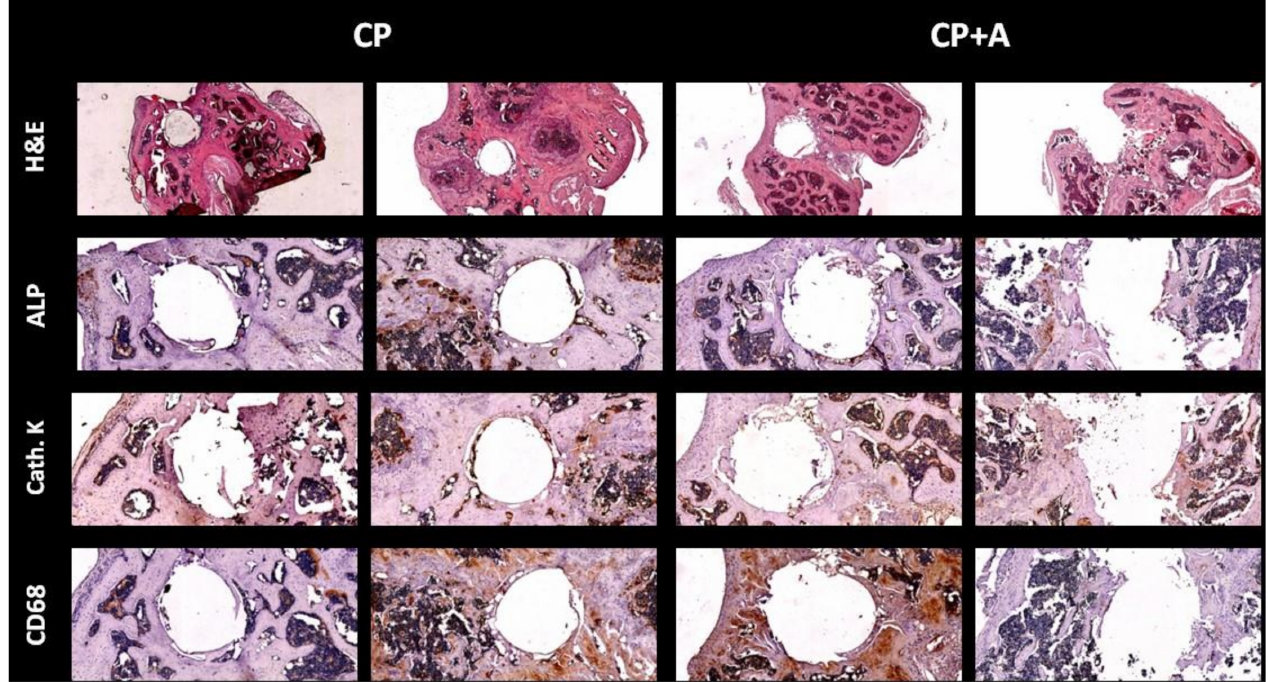
Figure 8. Immunohistochemistry for markers of different bone cells. Long bones were processed and immunohistology staining was carried out. Representative images stained for haematoxylin-eosin (H&E), tartrate-resistant acid phosphatase (TRAP) staining, cathepsin K (cath. K), alkaline phosphatase (ALP), and macrophages (cluster of differentiation 68, CD68). H&E images were taken at 4 × magnification. All immunostaining images were taken at 10 ×